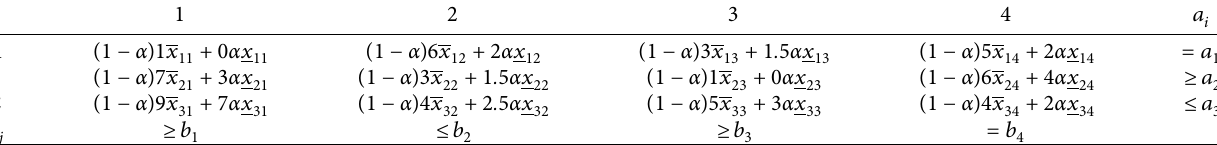
Table 3: Alpha cut representation of cost function for problem ( P ).